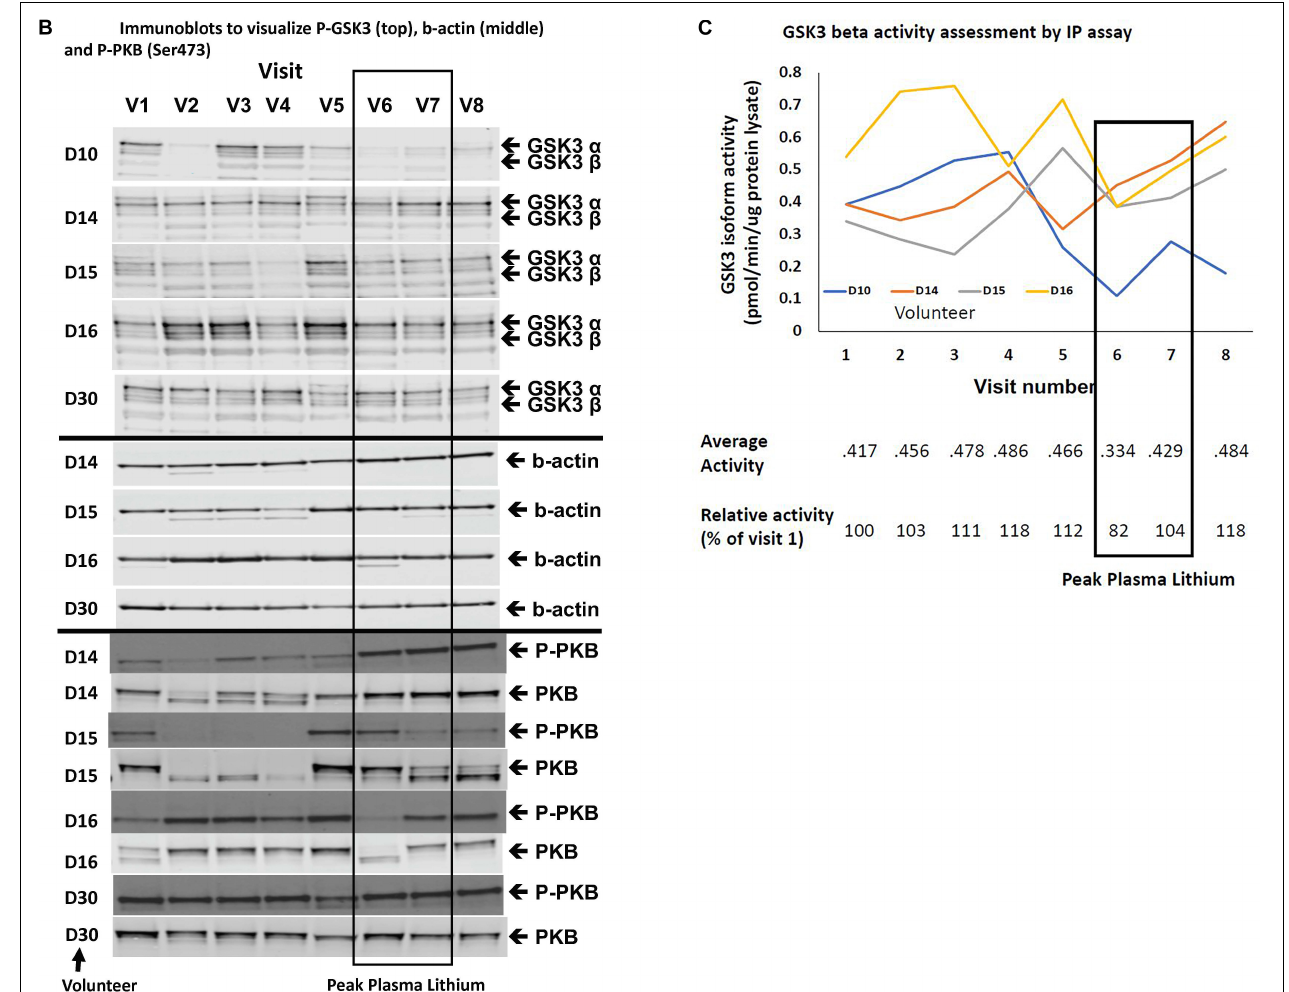
FIGURE 5 | Comparison of Biomarkers of GSK3 in human PBMCs isolated from volunteers with MCI treated with a stepwise increasing dose of Lithium (Study Arm 2). Protein lysates were prepared from PBMCs isolated from volunteers with MCI who underwent lithium treatment (see Figure 1 ). (A) Protein profiles (Coomassie staining) from the PBMC lysates of the five volunteers that completed eight visits. Equal amounts of protein were loaded in each lane (by Bradford assay). (B) Immunoblot of all of the lysates from the same five volunteers using the phosphoser9/21 GSK3 antibody. The box around visit 6 and 7 highlights the samples with the peak plasma lithium levels ( Table 3 ). (C) GSK3 β isoform specific activity in PBMCs isolated across the eight visits for four of the five volunteers that completed the study. The average GSK3 β activity for each visit and the average GSK3 β activity relative to the baseline activity for each volunteer are given under the graph. The box highlights samples (6 and 7) with the peak plasma lithium levels ( Table 3